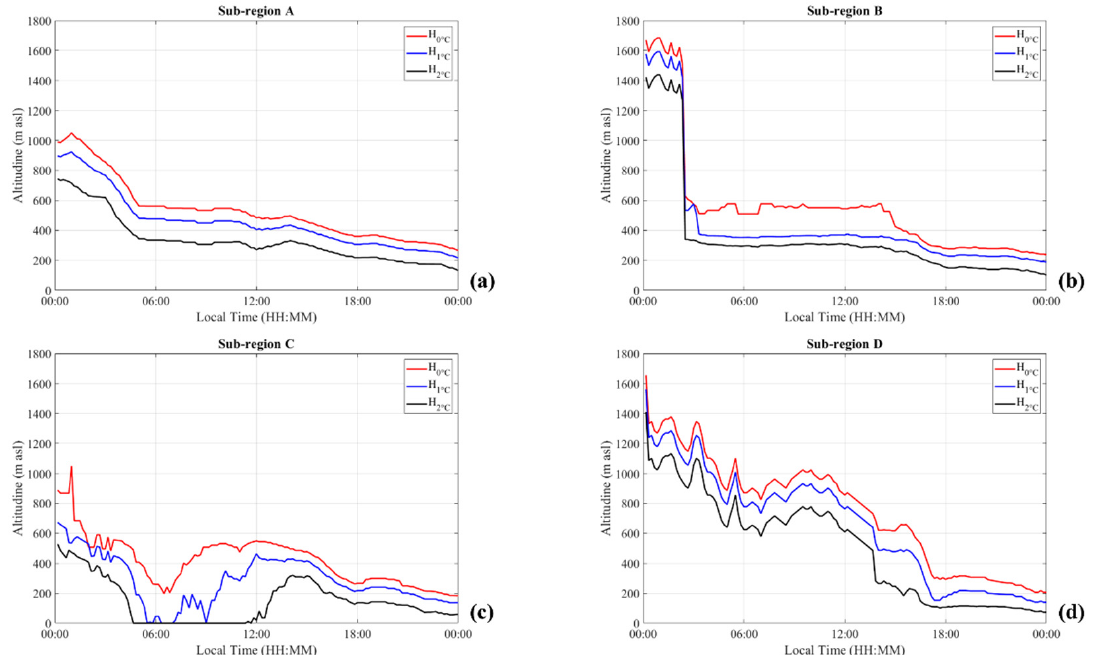
Figure 13. Behavior in time of the altitude of 0 °C, 1 °C and 2 °C isotherms ( H 0°C , H 1°C and H 2°C , respectively) on 13 February 2021. The four panels ( a – d ) show the H 0°C (red line), H 1°C (blue line) and H 2°C (black line) estimates for the sub-regions A, B, C and D, respectively, introduced in Section 3.3. The information about H 0°C , H 1°C and H 2°C have been retrieved in real time from AWS temperature data, which are available with a temporal resolution of 10 min. The time in x -axis is expressed as UTC.